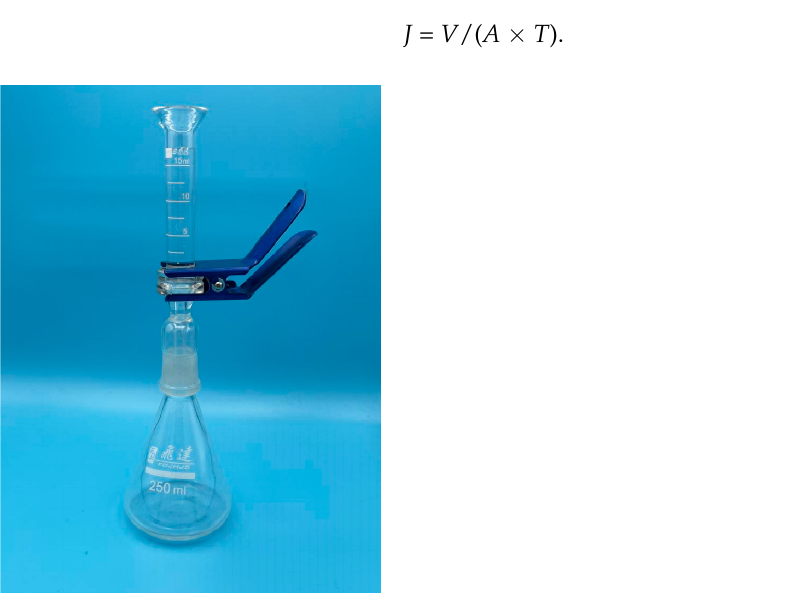
Figure 1. Water fl ux fi lter device